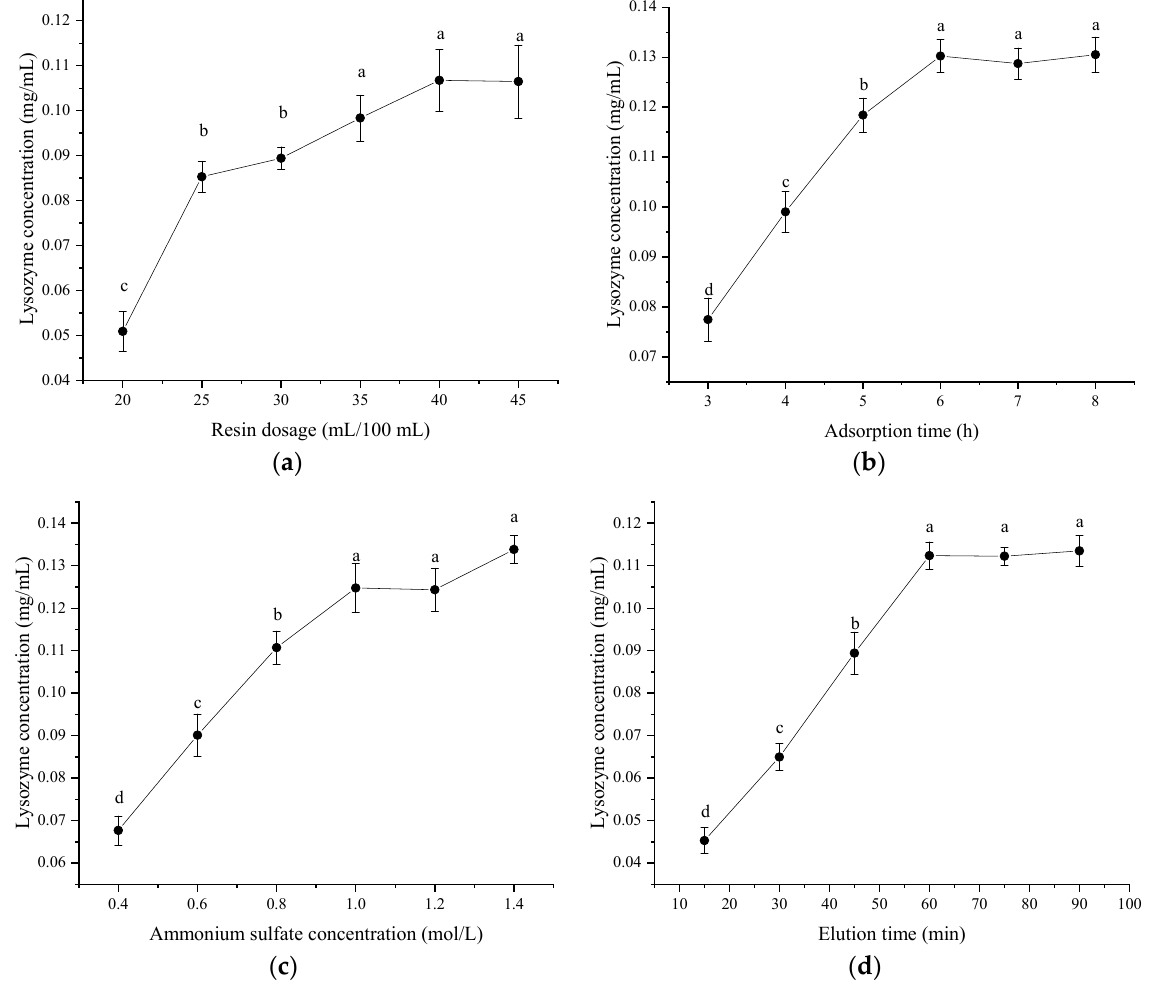
Figure 2. Effect of single factor on the concentration of lysozyme from salted duck egg white (SDEW). ( a ) Resin dosage, ( b ) adsorption time, ( c ) ammonium sulfate concentration; ( d ) elution time. Different lowercase letters ( a – d ) in the same graph represent significant differences ( p < 0.05).